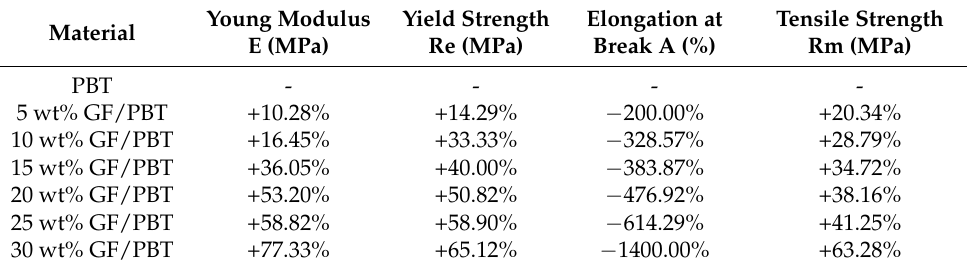
Table 2. Impact of GF reinforcement rate on the variation of the mechanical